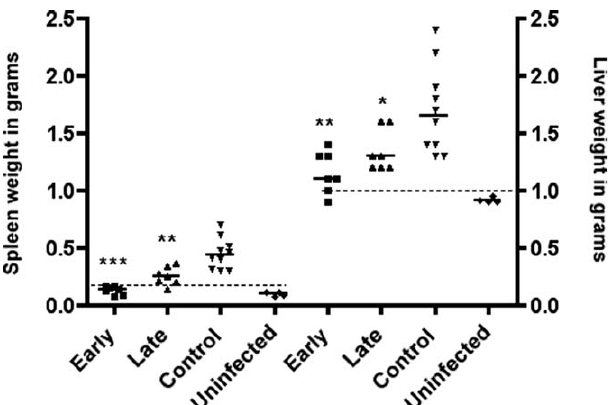
Figure 7. Early and Late Treatment of Mice with K11777 Decreases Hepato- and Splenomegalies in Mice Infected with S. mansoni Points represent data from individual mice which were combined from either two early or two late treatment experiments (see Figure 1). The horizontal bars represent median values: * p ¼ 0.02, ** p ¼ 0.004, *** p ¼ 0.0003. The hatched lines represent the baseline for age-matched uninfected mice.